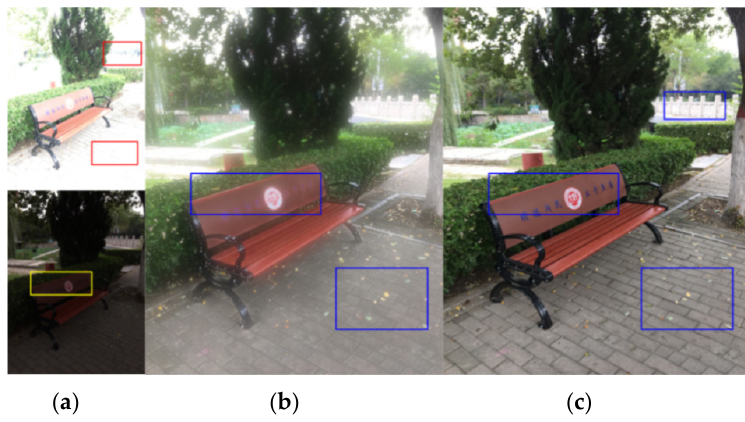
Figure 12. The fusion results of extreme-exposure pairs. ( a ) Over-and under-exposed raw image pairs. ( b ) JPEG fusion result using our method. ( c ) The result of the proposed method.